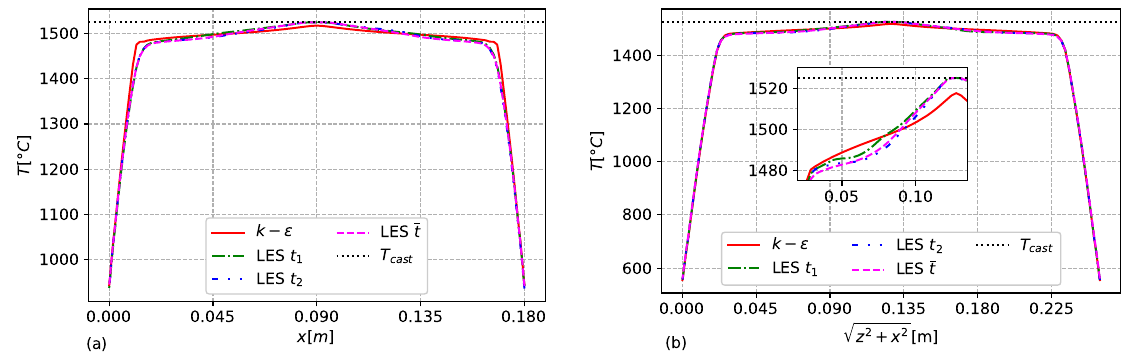
Figure 11. Temperature field. ( a ) At HL1; ( b ) At HL2.